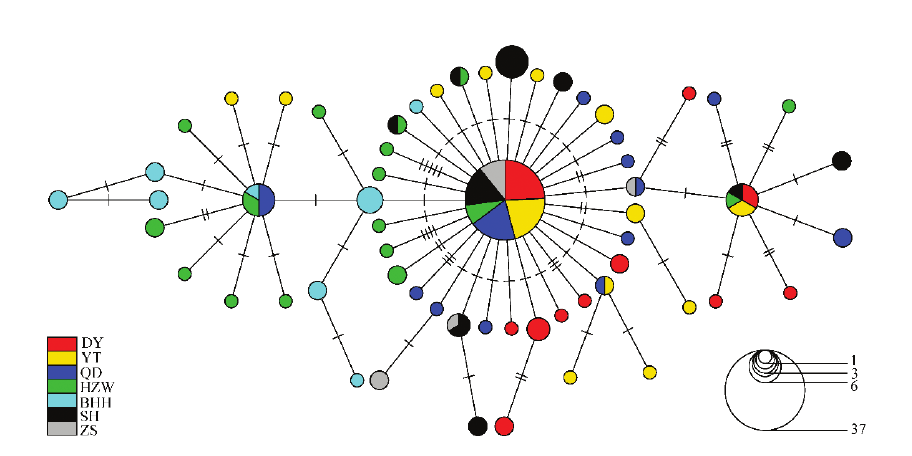
Figure 3. Minimum spanning network showing genetic relationship among mtDNA control region hap- lotypes in J. grypotus (Circles represent haplotypes with sizes proportional to their respective frequencies. Tick marks represent deduced numbers of nucleotide substitutions along each